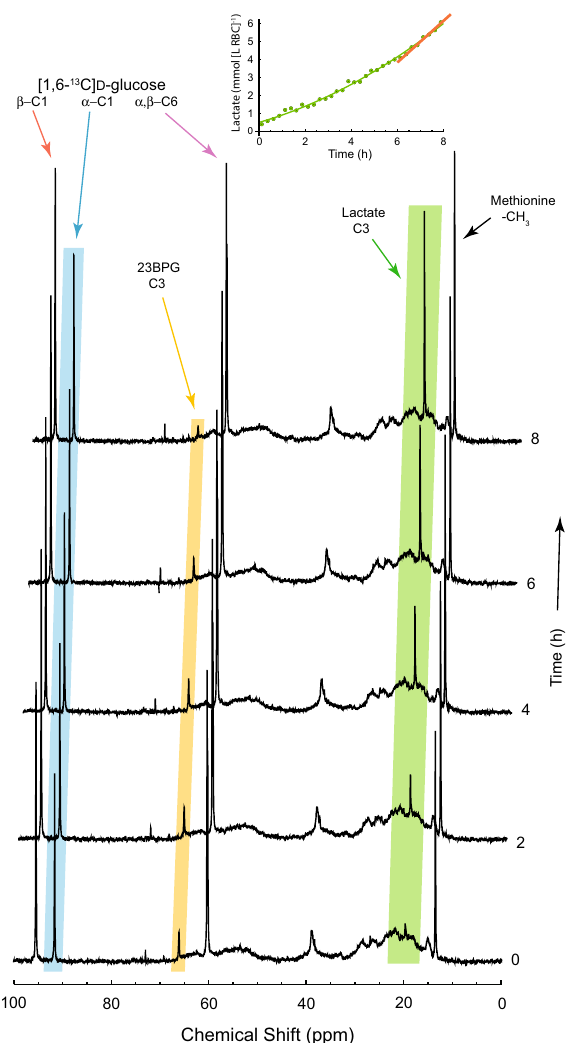
Figure 5. 13 C NMR (100.46 MHz) spectral time course of glycolysis in RBCs loaded with 5FBAPTA, at ~ 34 °C. 3 mL RBCs ( Ht = 0.75) loaded with 5FBAPTA-AM were supplemented with [1,6- 13 C]d-glucose and 13 CH 3 -l- methionine (final concentrations averaged over the sample volume were 8 mM and 7 mM, respectively). The times indicated on the right are relative to an arbitrary start time when the sample was removed from storage at 4 °C, after preparation 1 h before. Every eighth spectrum is shown. The inset shows the concentration of lactate corrected to account for Ht . A quadratic (0.489 + 0.368 t + 0.0398 t 2 ; solid green) was regressed onto the full time course data set (green dots) that included the transient stage of the progress curve (see Discussion for why this routinely occurred), and the straight line ([−3.10 ± 0.84] + [1.15 ± 0.11] t ; solid orange) was regressed onto the integrals from the more linear last 2 h (8 points). The labels indicate assignments to the main solutes: glucose; 2,3 bisphosphoglycerate (23BPG); lactate; and the chemical shift and intensity reference methionine (13.5 ppm). Green highlighting emphasizes the rising lactate resonance; orange, the emergence and then decline of 23BPG; and blue, the C1 atom of the α-anomer of glucose. (The other two glucose resonances are plain.) The integral of the methionine resonance remained constant, within experimental error. Spectra were recorded every 15 min. NMR settings: BBO probe; RF sampling pulse duration 13 µs based on a 90° pulse of 35 µs and estimated T 1 of ~ 5 s hence the Ernst angle value; broadband gated decoupling of 1 H was used to remove 1 H– 13 C splitting in the spectra; the inter-FID delay was 2.84 s; 296 complex FIDs were summed per spectrum; a line broadening factor of 5 Hz was applied in exponential multiplication of the FIDs prior to Fourier